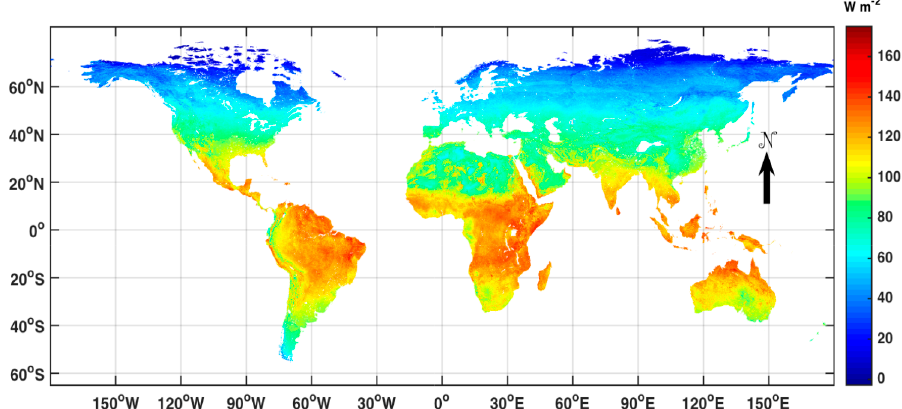
Figure 8. Mean daily (24-h) global net-radiation from MODIS.